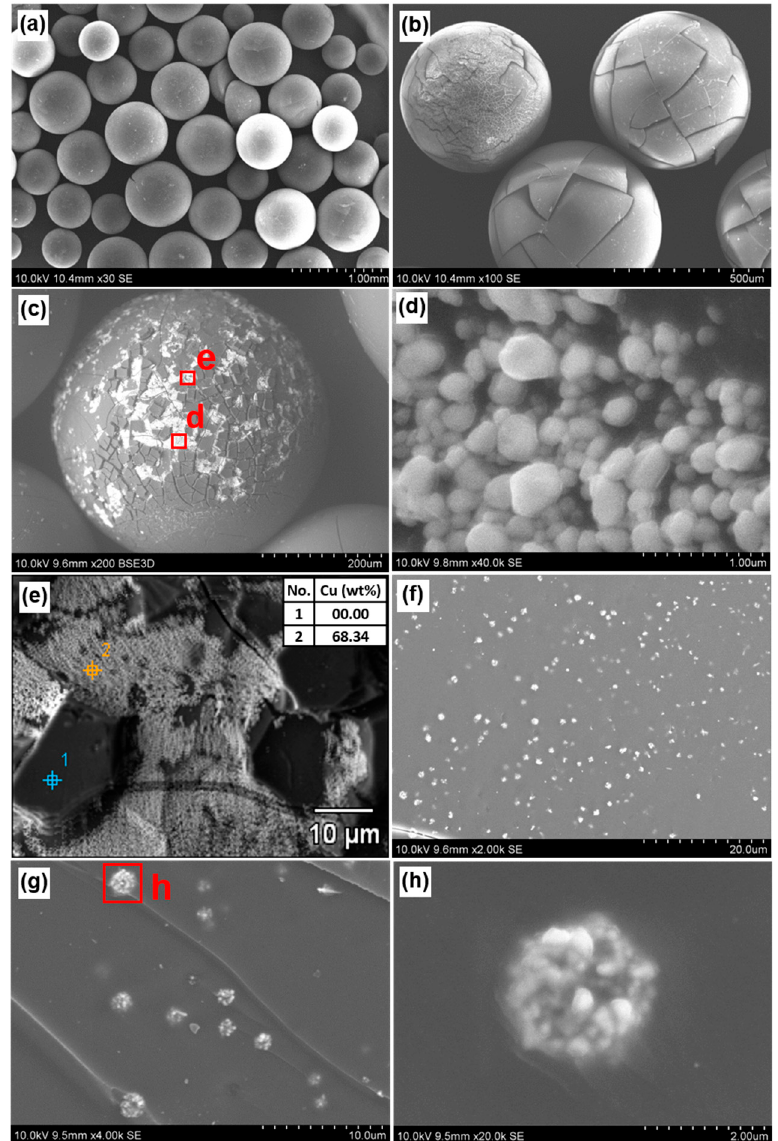
Figure 4. SEM images and EDS analysis of the G/An/Cu ( a )–( e ) surface, ( f )–( h ) inside.